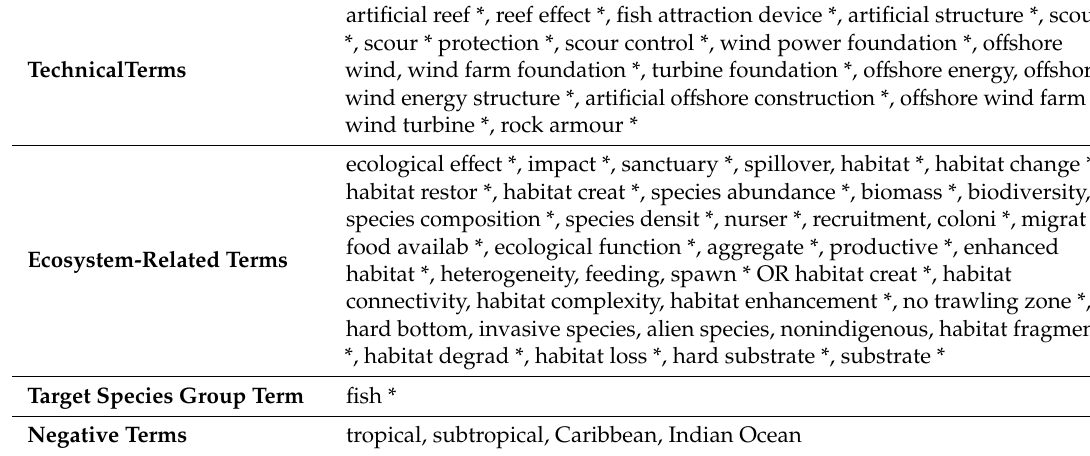
Table 1. Selected search terms used in “Web of Science” and “Scopus”.